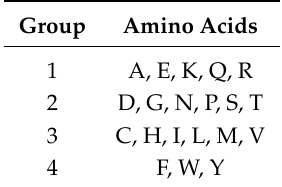
Table 3. The encoding of amino acids with the best